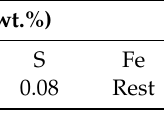
Table 1. Chemical composition of DX51D hot-dip galvanized